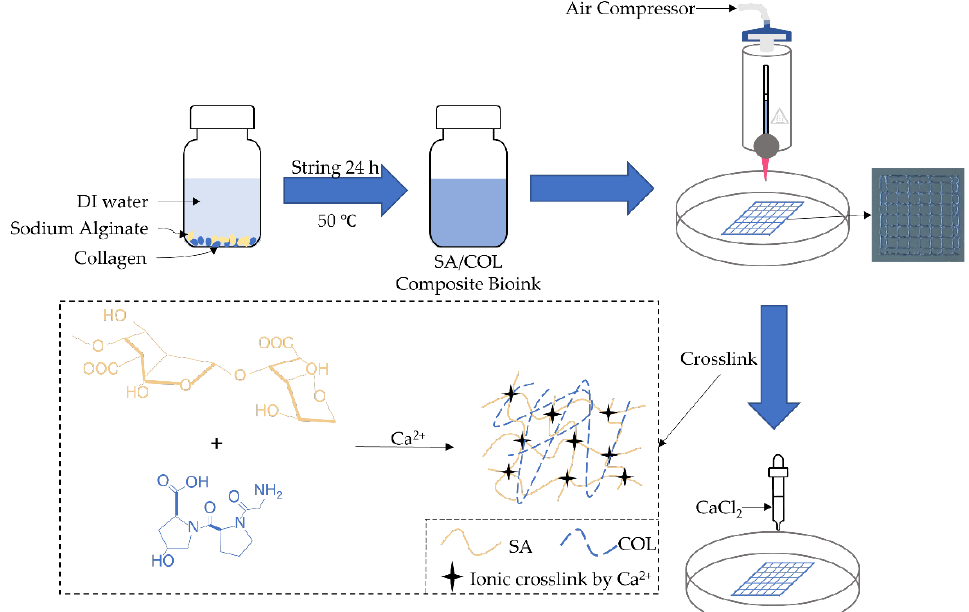
Figure 1. Schematic illustration of the bioprinting process.